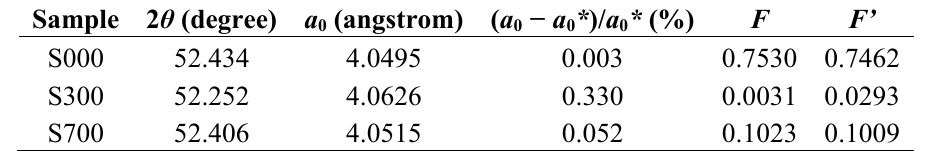
Table 1. The preferred orientation factors F , lattice parameter a 0 , and angle of diffraction (2 θ ) of the (200) plane of α -Al of samples obtained from X-ray diffraction.